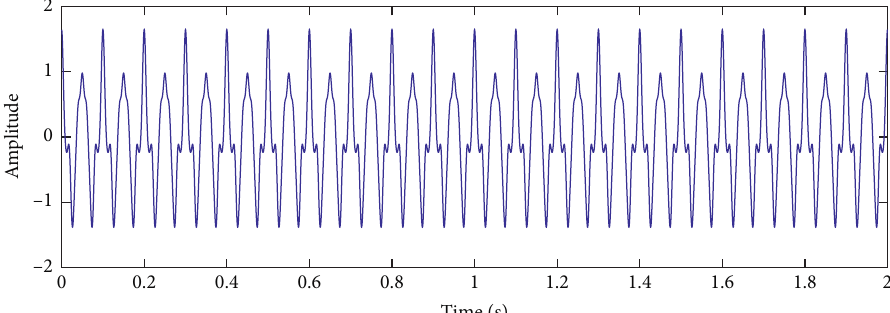
Figure 4: Waveform of the simulated